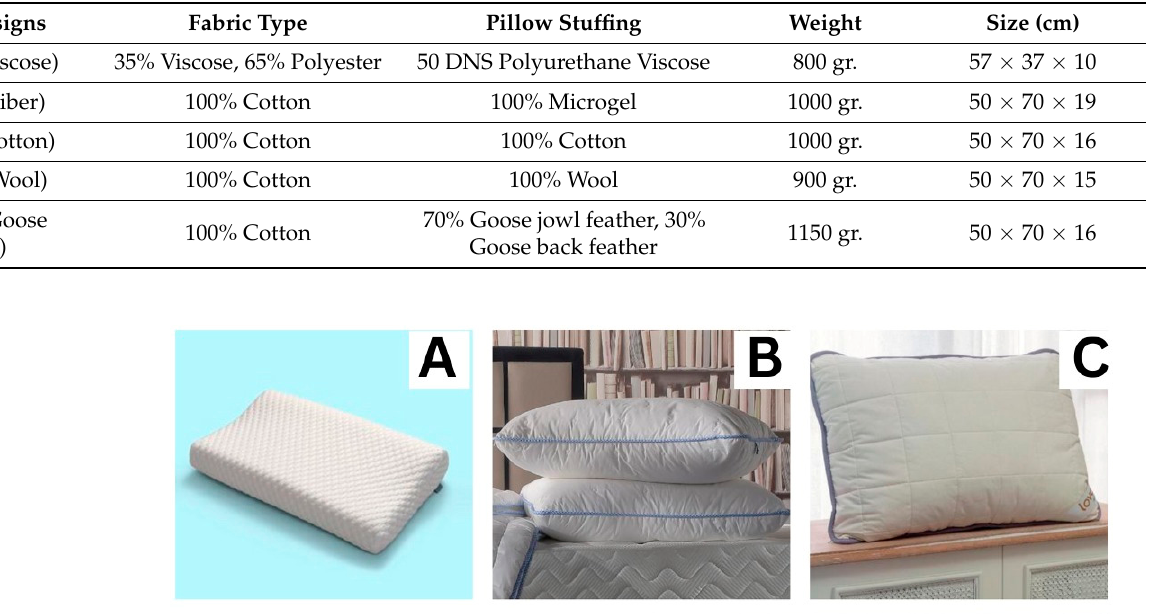
Table 1. Structural features of pillow designs.